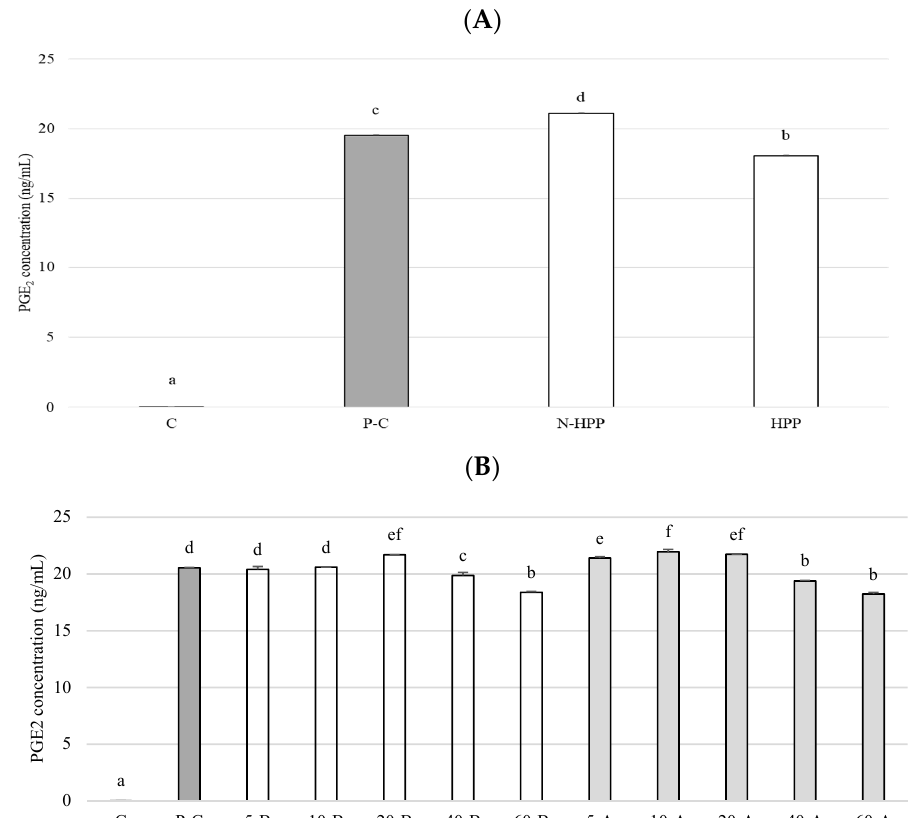
Figure 5. PGE 2 content. ( A ) Untreated group and high-pressure-treated group. (cid:4) C: control, (cid:4) P-C: positive control (LPS induced); (cid:3) N-HPP: LPS induction + Non HPP untreated group; (cid:3) HPP: LPS induction + high-pressure group, 400 MPa, 15 min. ( B ) Broccoli extracts of different concentrations, pre-/post-LPS treated. (cid:4) C: control (not LPS induced); (cid:4) P-C: positive control; (cid:3) 5-B broccoli extracts 5 ppm, pre-LPS treated; (cid:4) 5-A broccoli extracts 5 ppm, post-LPS treated. All data are presented as the mean ± SD ( n = 3). Different letters in the same row indicate significantly different results ( p <